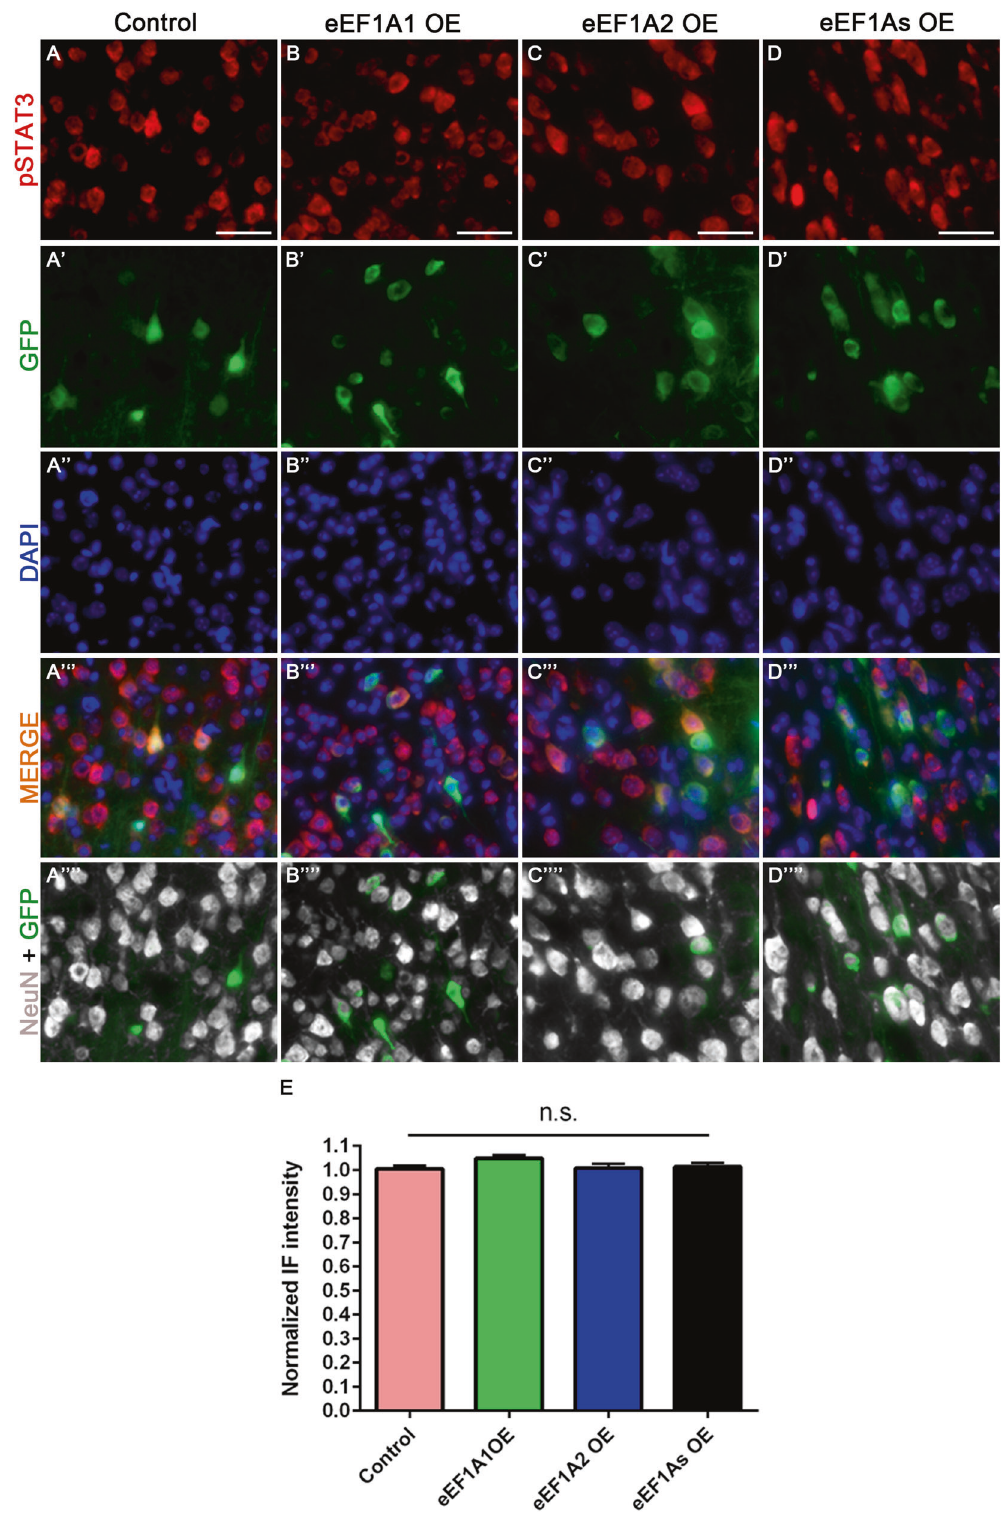
Fig. 4 Overexpression of eEF1A proteins does not activate STAT3 signaling. Representative images of pSTAT3, GFP (viruses), and NeuN staining at the layer V of the right sensorimotor cortex of injured control mice (AAV-GFP injection) ( A – A ”” ); injured eEF1A1-OE mice ( B – B ”” ); injured eEF1A2-OE mice ( C – C ”” ); and injured eEF1As-OE mice ( D – D ”” ). E Quanti fi cation of pSTAT3 immunoreactivity. Scale bars: 50 μ m. Control, 12 mice; eEF1A1, 10 mice; eEF1A2, 10 mice; eEF1As, 8 mice; PTEN cKO, 4 mice per genetic condition; 20 cells quanti fi ed per mouse. Stats: One- way ANOVA with Kruskal – Wallis Test revealed no signi fi cant differences. Bars show mean ± SEM.